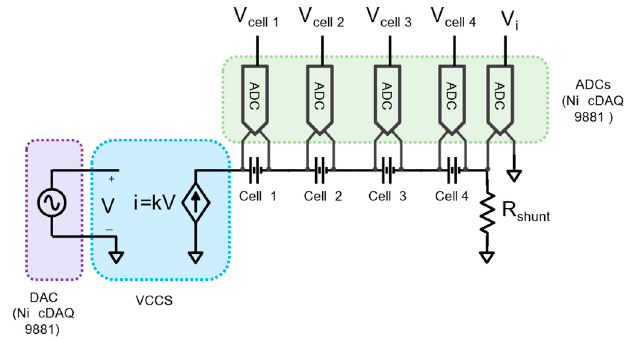
Figure 4. Flowchart of the cycling and measurement procedure.